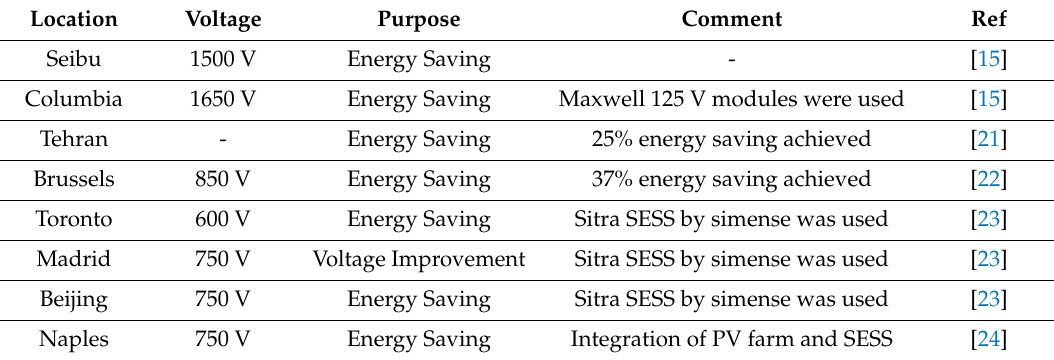
Table 2. Application of supercapacitor energy storage (SESS) in rail transit systems.